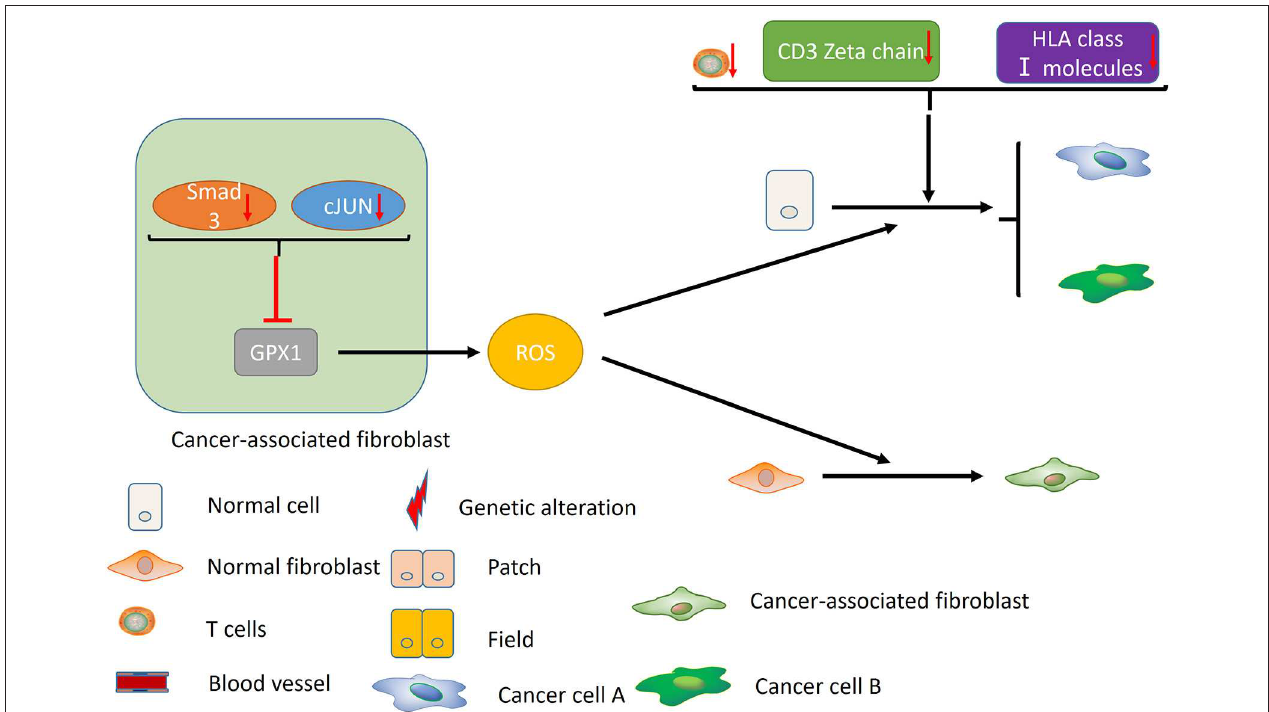
FIGURE 2 | Immune factors and CAFs contribute to the development of MPCs. Decreased T-cell numbers, CD3 zeta chain and HLA class I molecules may promote the development of MPCs by inducing immunosuppression. In the CAFs, reduced expression of Smad3 and cJUN suppress the activity of GPX1, leading to the elevation of extracellular hydrogen peroxide. High hydrogen peroxide level in the microenvironment induces the conversion of normal fibroblast to CAF phenotype, and promotes the occurrence of